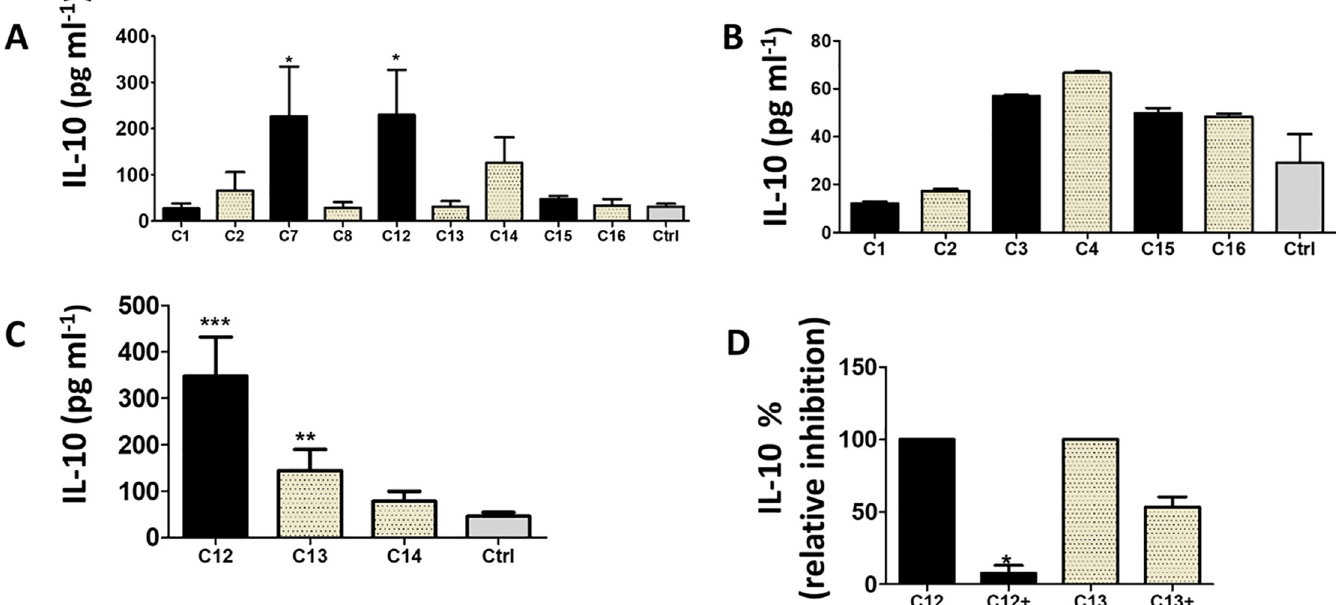
Fig 2. Envelope stimulation of MDDC IL-10 secretion. A) Luminex assay was used to measure the concentration (pg ml -1 ) of IL-10 released by 7 donor MDDCs in response to pseudovirus (PSV) C1, C2, C7, C8, C12-C16 and levels were compared using Mann Whitney two tailed comparison. B) IL-10 ELISA was used to measure the concentration (pg ml -1 ) of IL-10 released by 4 donor MDDCs in response to PSV C1, C2, C3, C4, C15 and C16 and levels were compared using Mann Whitney test. C) Purified recombinant gp140 (C12-C14) were used to stimulate seven donor MDDCs and the secretion of IL-10 was measured by Luminex assay. Concentration of IL-10 was compared between the clones using Wilcoxon signed rank test. D) Three donor MDDCs were stimulated with PSV (C12 and C13) after pre-incubation with recombinant DC-SIGN (+) and IL-10 levels relative to uninhibited MDDC stimulation (%) were compared by paired t test. C1 & C2, C3 & C4, C7 & C8, C12, C13 & C14 and C15 & C16 are Env pairs from the same patient at transmission and chronic infection,